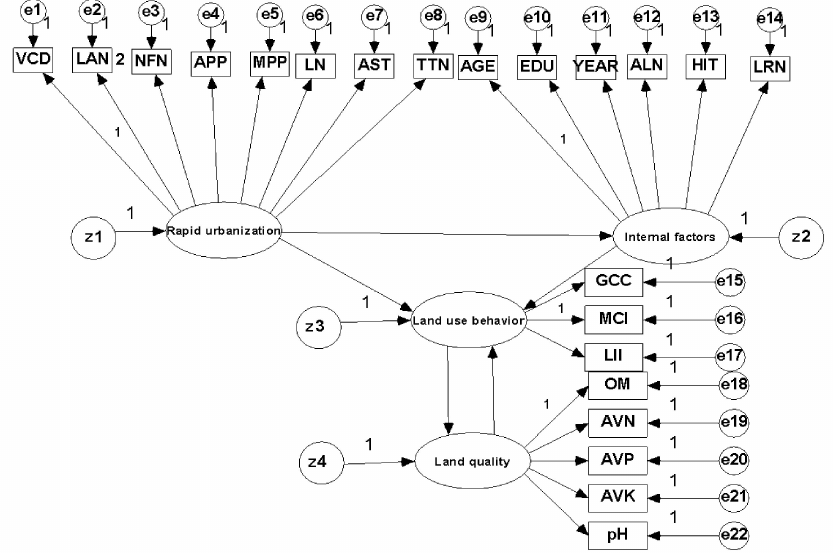
Figure 3. The structural equation model (SEM) of the land-use behavior to land quality in the process of